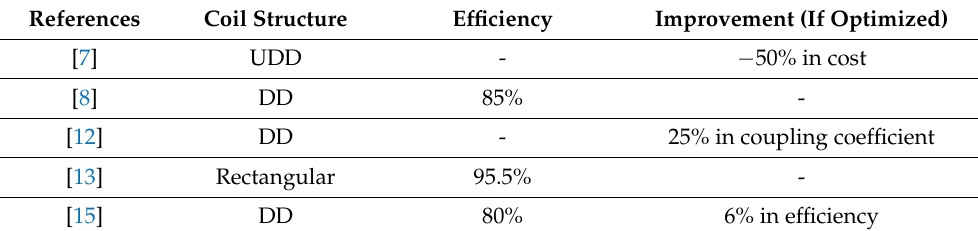
Table 1. Efficiency and improvement results in key referenced